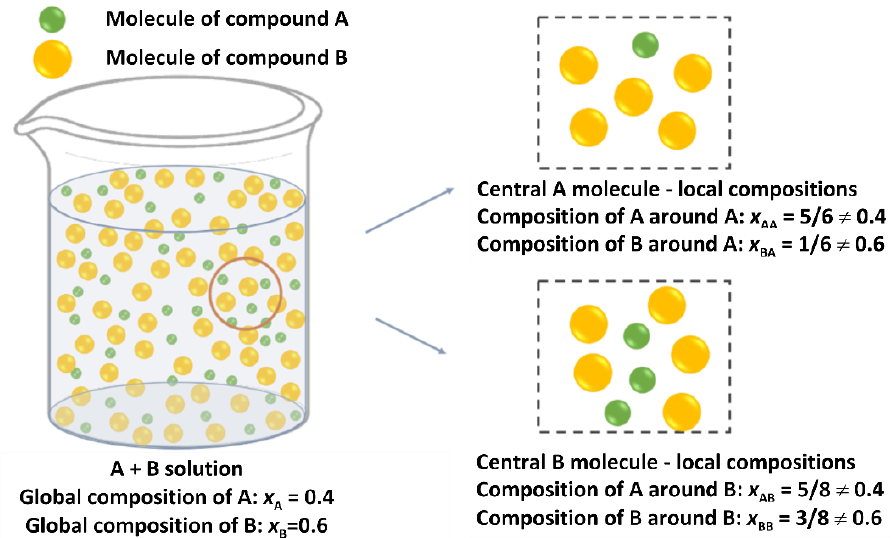
Figure A1. Molecular conceptualization of the NRTL model. On the right are the cells that correspond to the hypothetical solutions with central molecules A or B.